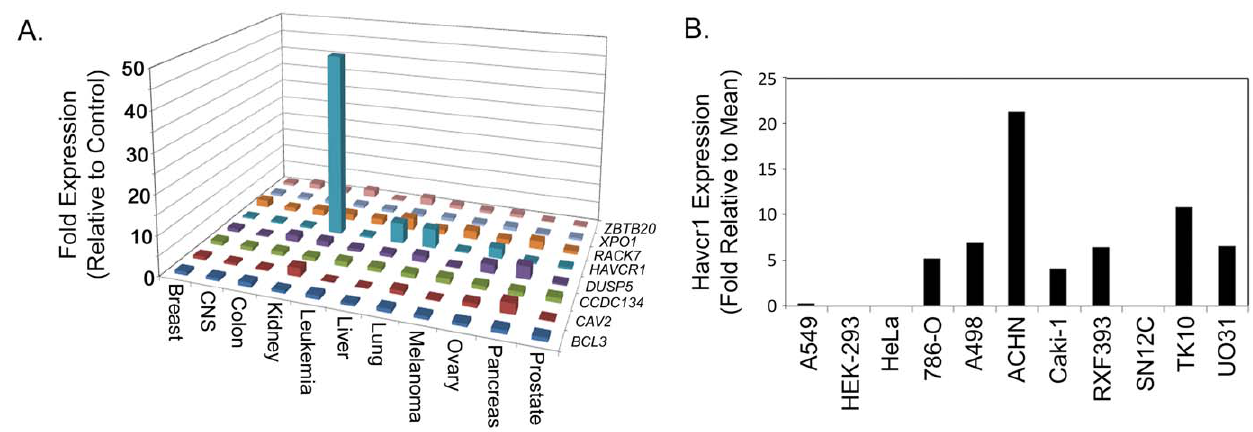
Figure 2. HAVCR1 is more abundantly expressed in human kidney cells than in human cell lines resistant to e -toxin. A . Gene expression data from a publicly-available microarray experiment were reported as fold increase over mean expression levels and included data for 8 genes listed in Table 1 [40,41]. Data was sorted based on tissue of origin and the mean expression level of each gene was determined for each tissue. Results are expressed as the fold increase over the expression level observed in three control cell lines (A549, HEK-293, and HeLa) known to be resistant to e -toxin. B . Gene expression data from a publicly-available microarray experiment reported as fold increase over mean expression levels among all 83 cell lines are displayed for three cell lines known to be resistant to e -toxin (A549, HEK-293, and HeLa) and for 8 cell lines derived from human kidney with unknown sensitivity to e -toxin [39].